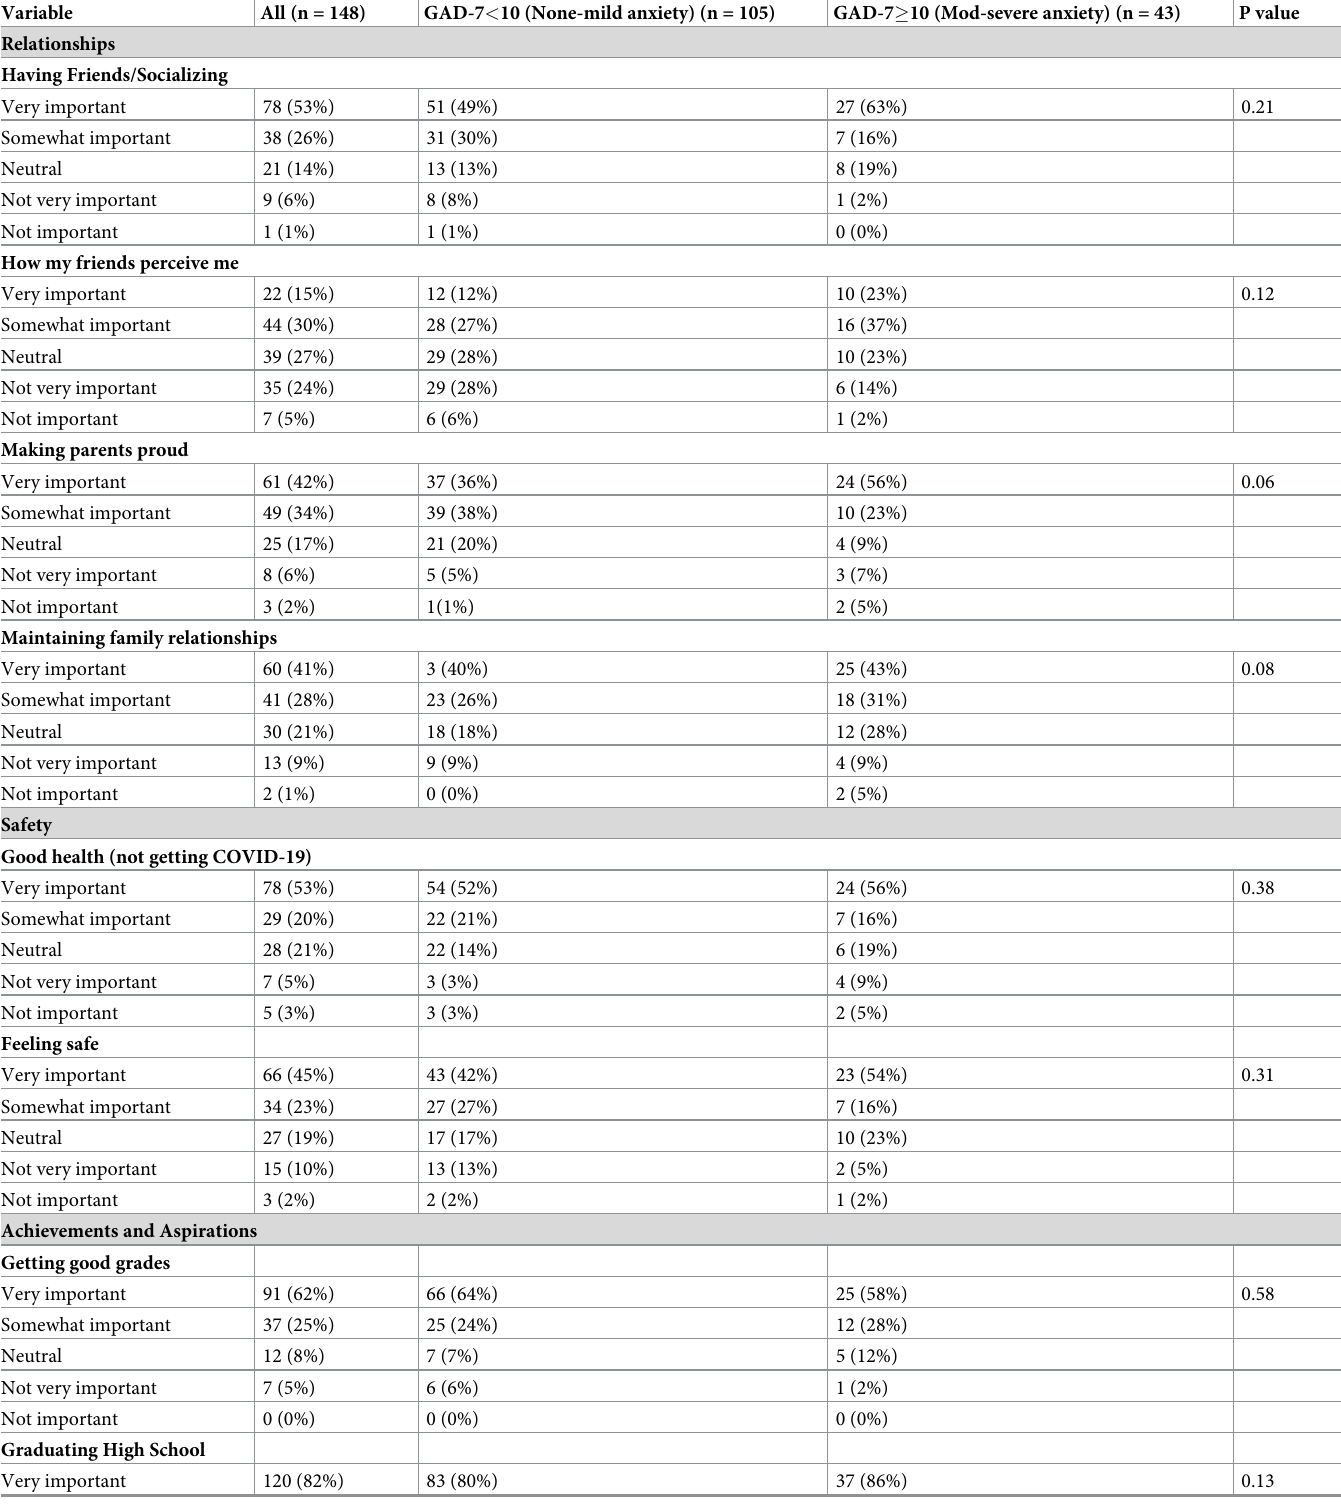
Table 4. Importance of relationships, safety, achievements, aspiration and opportunities stratified by anxiety